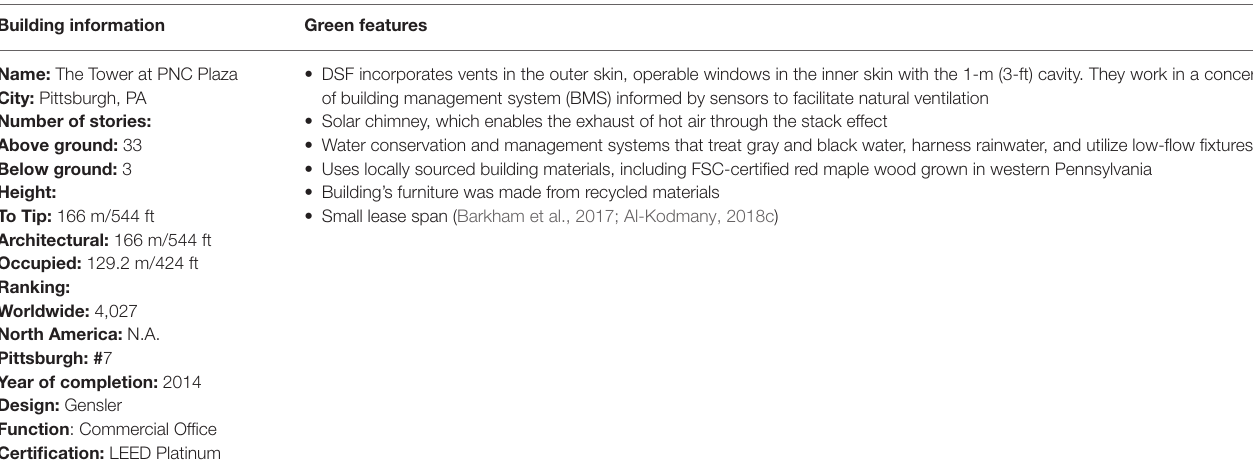
TABLE 4 | The Tower at PNC Plaza: Key green features. Building information Green